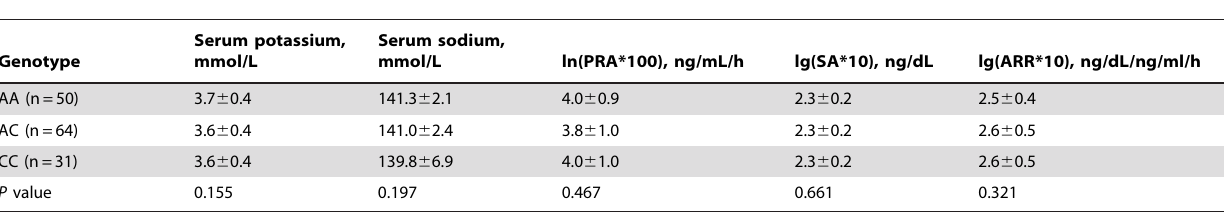
Table 5. Association between the genotypes of rs2604204 and intermediate phenotypes of male patients with PA.